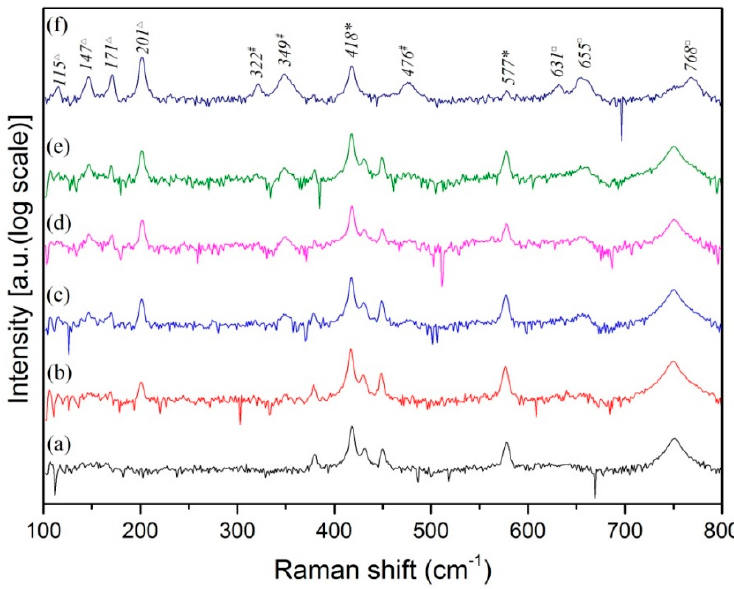
Figure 5. Raman spectra of β -Ga 2 O 3 films grown with various VI / III ratios: ( a ) sapphire substrate; ( b ) 66.9 × 10 3 ; ( c ) 22.3 × 10 3 ; ( d ) 11.2 × 10 3 ; ( e ) 7.4 × 10 3 ; ( f ) 5.6 × 10 3 . ∗ , the Raman peaks related to sapphire. ∆ , the Raman peaks related to tetrahedral-octahedra chains. #, the Raman peaks related to GaO 6 octahedra. □ , the Raman peaks related to GaO 4 tetrahedra.